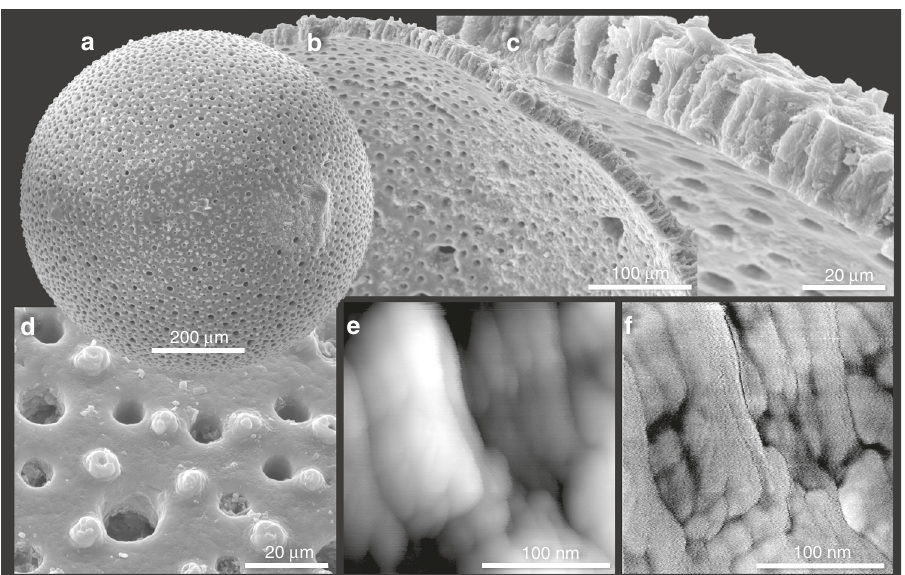
Fig. 1 Images of a pristine planktonic foraminiferal test ( Orbulina universa ) from the macroscopic scale to the submicrometer-scale of the granular calcite “ building blocks ” . a – d Scanning electron microscopy (SEM) images of the outer surface exhibiting a large, porous surface area. e , f Atomic force microscopy (AFM) height ( e ) and phase ( f ) mode images. Courtesy of Prof.